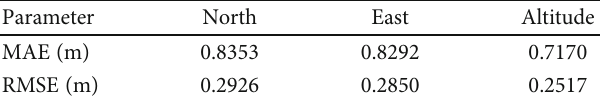
Table 3: Error between desired path and trajectory.